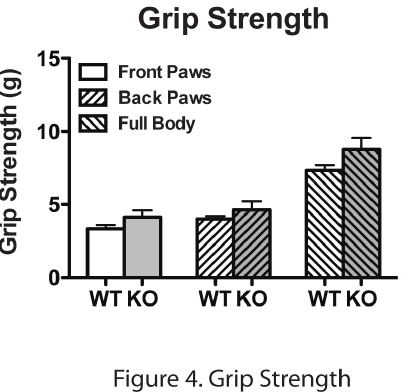
Figure 4. ANP32E-deficient mice do not show defects in grip strength. Mice were analysed for grip strength of front paws, hind paws, and total grip strength. No statistically significant differences were noted by paired t-test